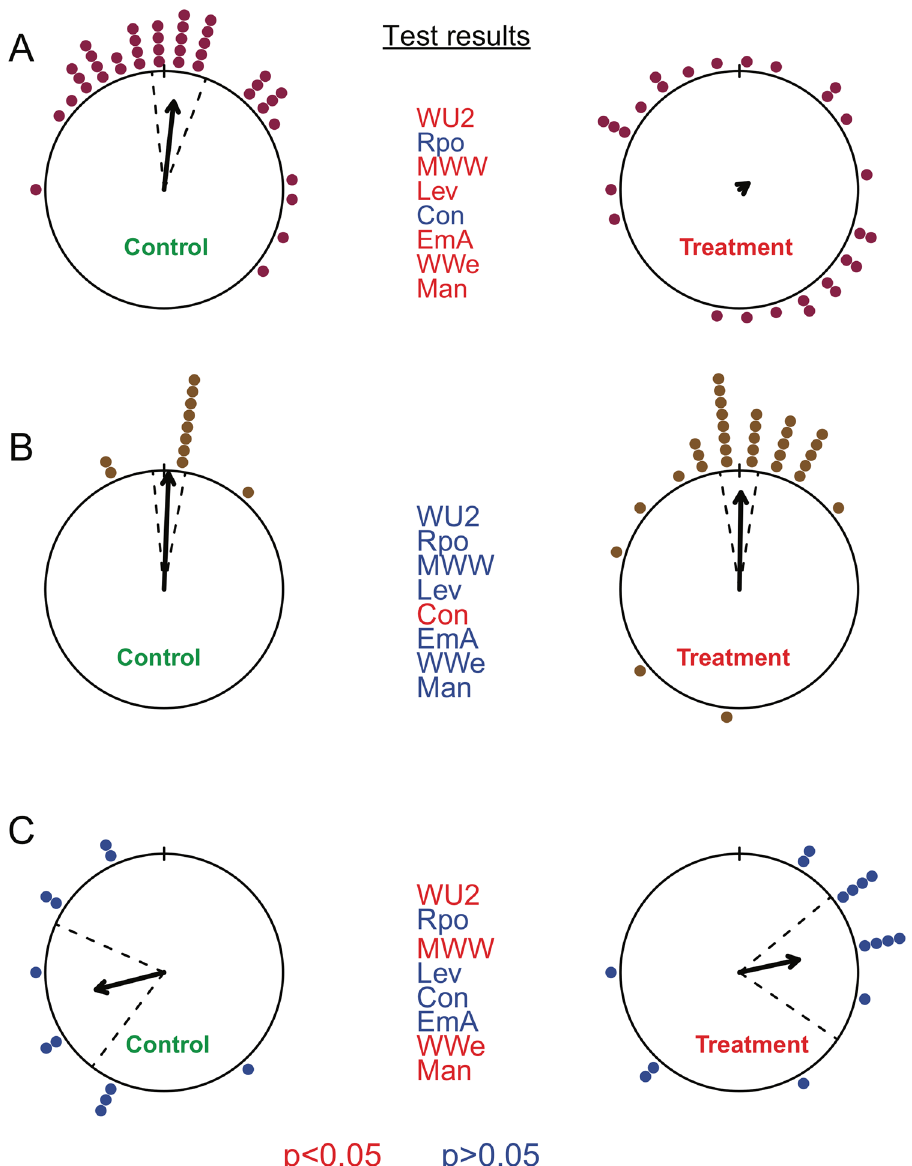
Figure 6. Results from example data. Shown are results of pigeon ( A ), ant ( B ) and bat orientations ( C ). Control groups are on the left panels and experimental groups on the right. The tests are abbreviated according to Table 1, significant test results are indicated in red with asterisk and non-significant in blue. For each circular plot directional data is shown as dots on the circle (each dot is one individual), the arrows represent the mean direction and the dashed line the 95% confidence